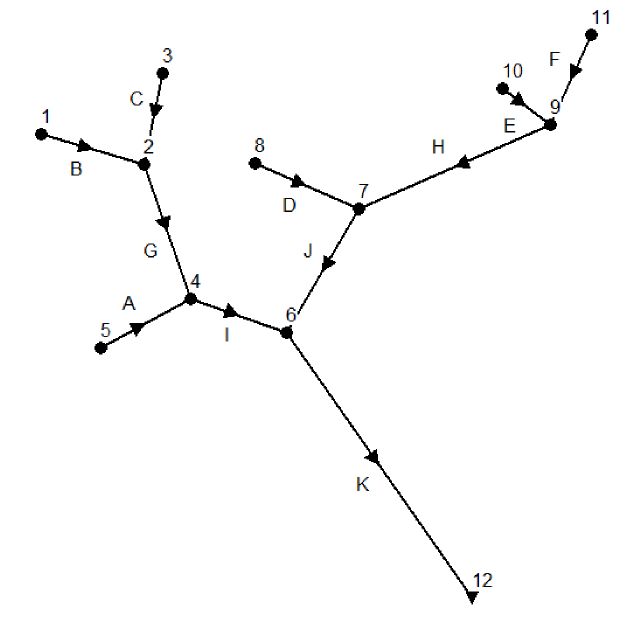
Figure 2. Hypothetical river network. Table 1. Hydraulic characteristics of the river